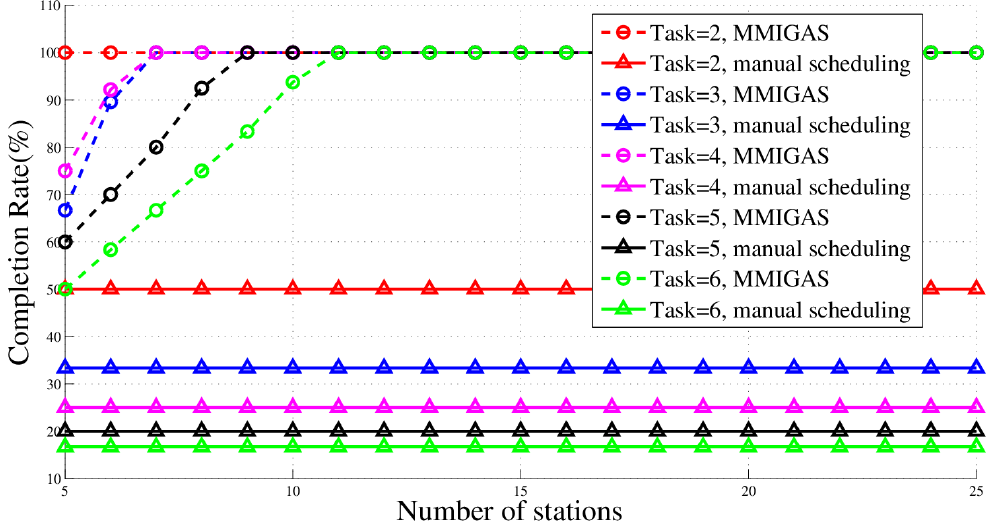
Figure 15. Completion rate in different scenario.